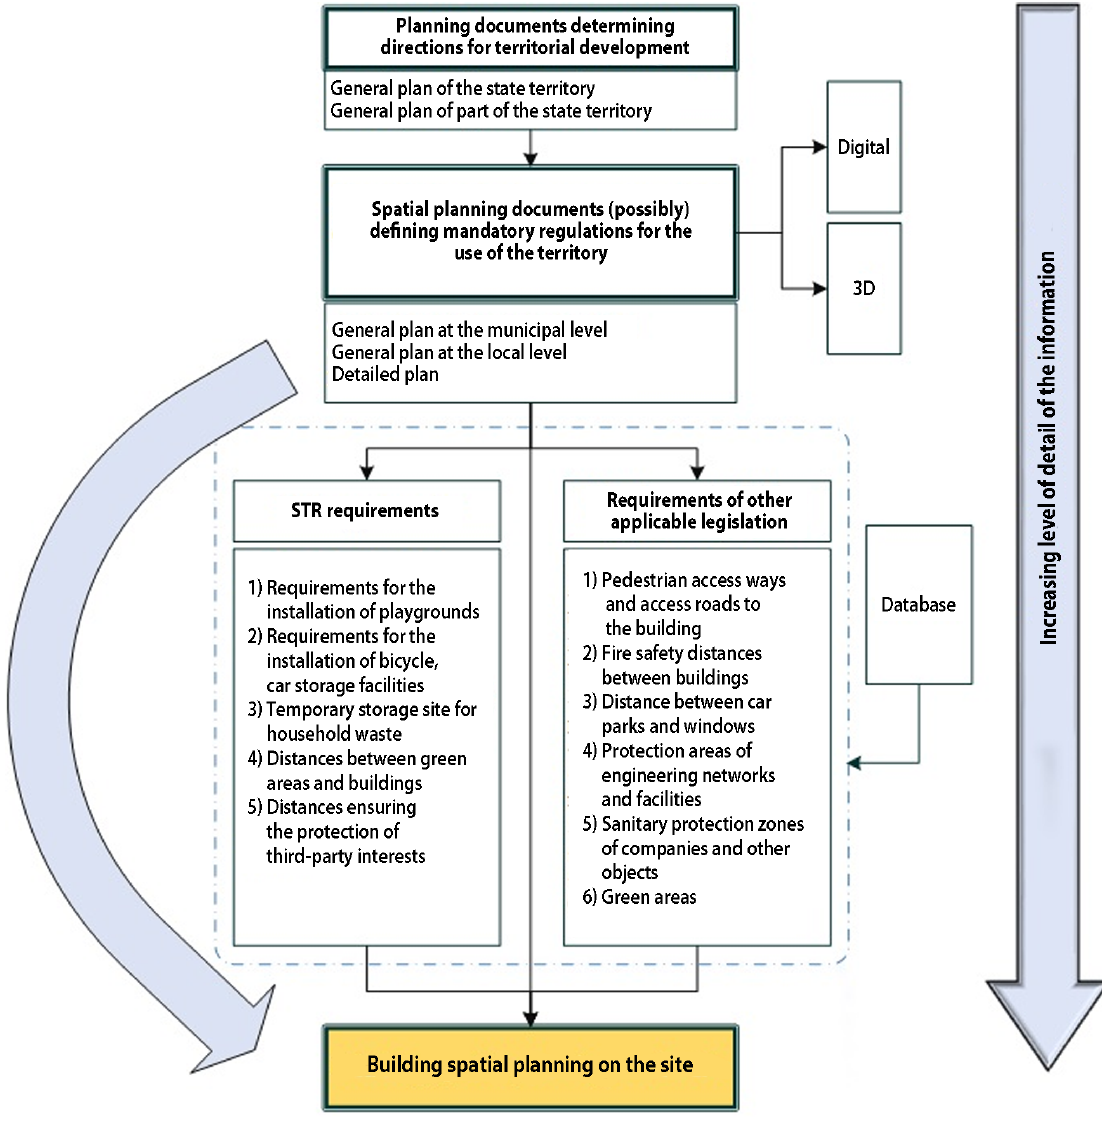
Fig. 1. Flowchart of links of site and building spatial planning with spatial planning documents and legal